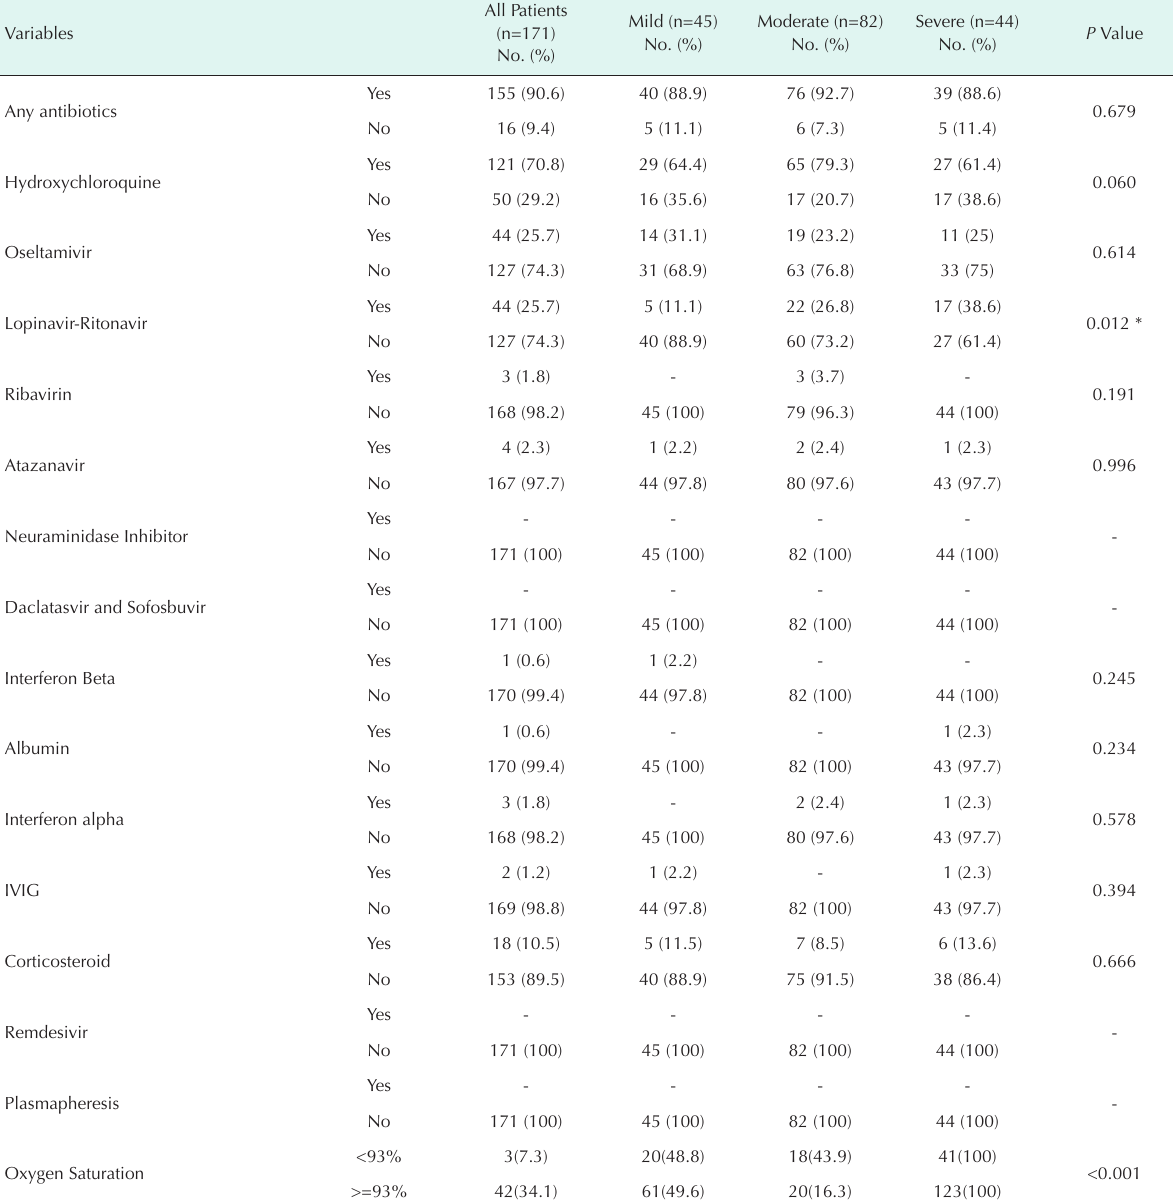
Table 5. The Association between Different Groups of Severity With Medications and Treatment Methods Variables